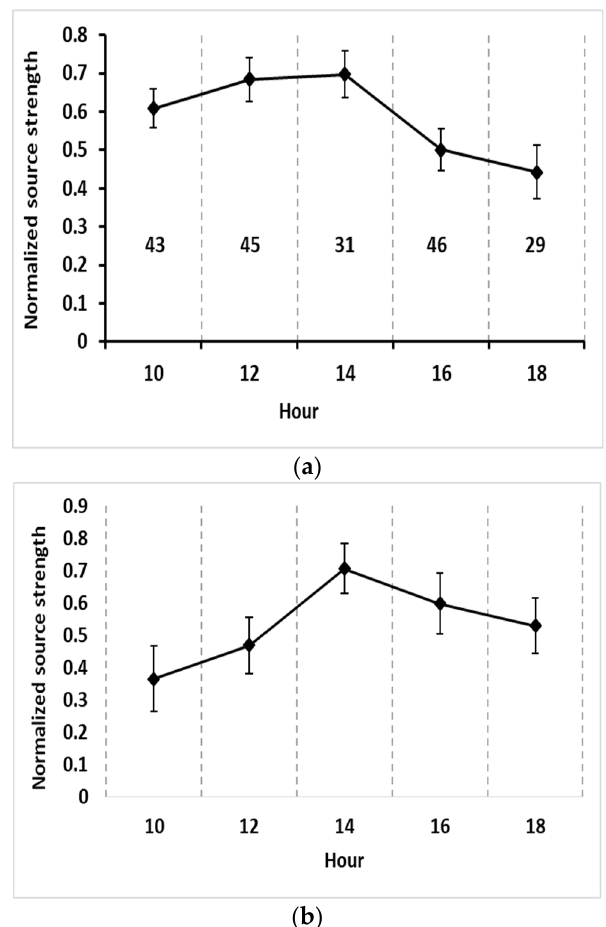
Figure 2. Seasonal seed source strength in the two experiments. ( a ) Hourly average seed source strength measured in the Illinois source field from 29 August 2013 to 12 October 2013; ( b ) hourly average seed source strength measured in the Tennessee source field from 18 August 2014 to 29 September 2014; ( c ) estimated daily released grains per plant (08:00 to 20:00) during the main re- lease period (3 September to 24 September) for Illinois (black solid line) and Tennessee (grey dot- ted line).